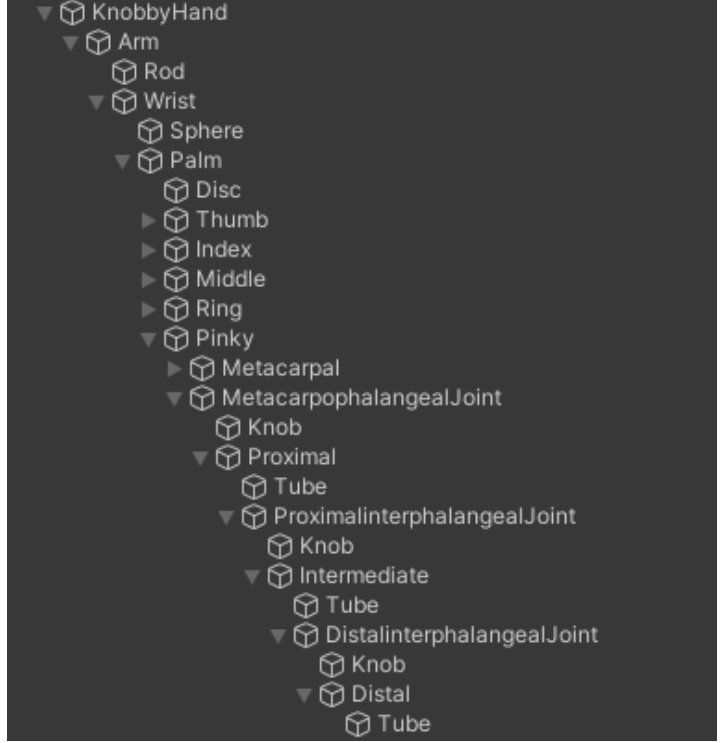
Figure 3. Transform hierarchy